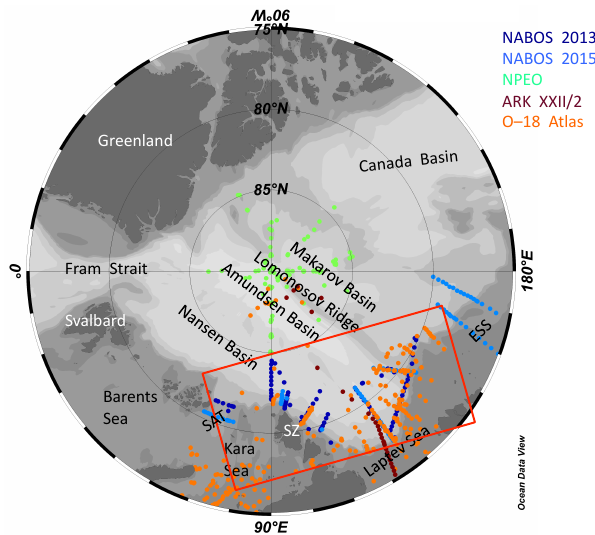
Figure 2. General map of Arctic Ocean showing study area (red box) and stations occupied during 2013 cruise (dark blue circles) and 2015 cruise (light blue circles) as well as stations occupied as part of the North Pole Environmental Observatory (green circles), ARK XXII/2 expedition (dark red circles), and O-18 Atlas (orange circles). SAT, St. Anna Trough; SZ, Severnaya Zemlya; ESS, East Siberian Sea. The map was created using Ocean Data View software (version 4.7.6; Schlitzer,